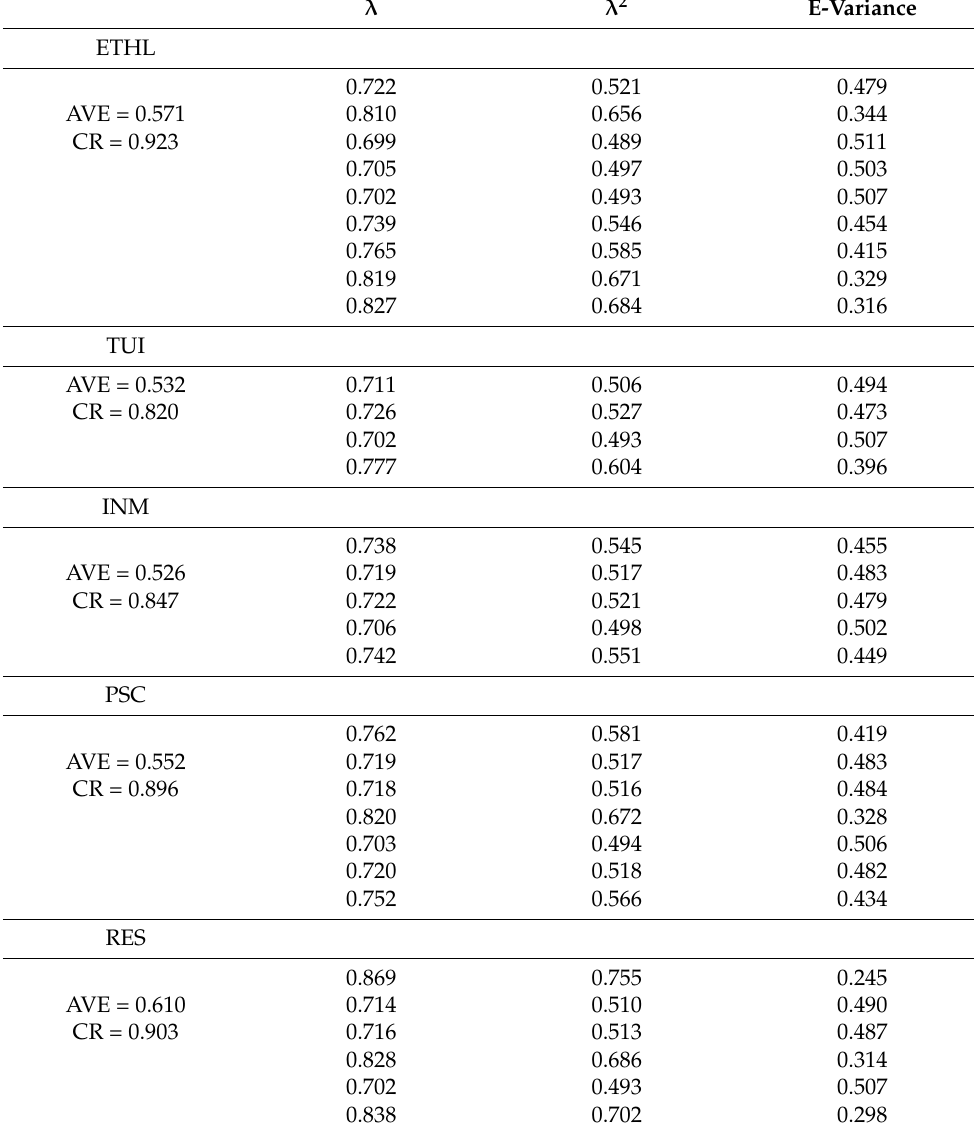
Table 3. Validity and